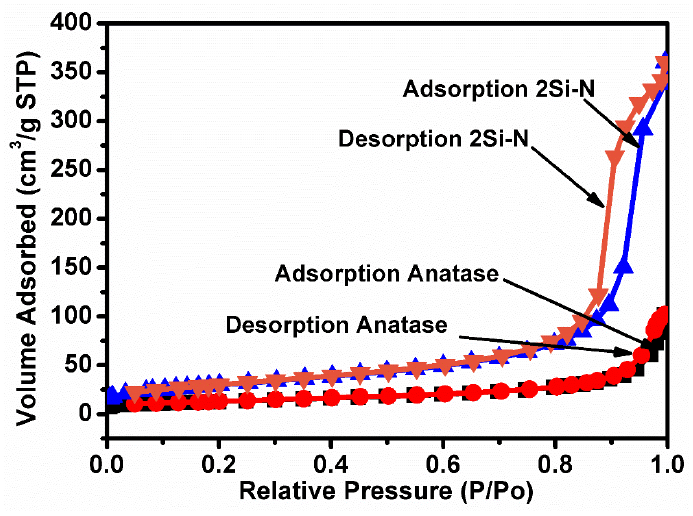
Figure 7. N 2 adsorption/desorption isotherms of the samples 2Si-N and raw anatase TiO 2 powder.